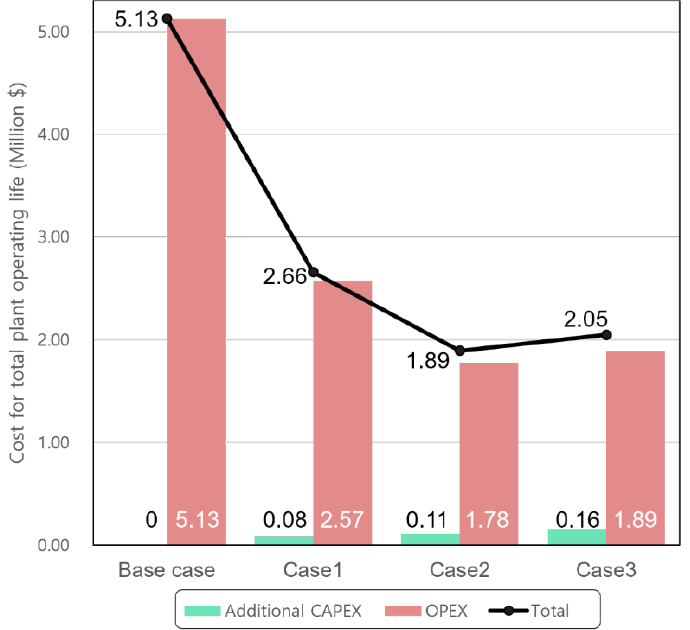
Figure 7. Result of the economic analysis.